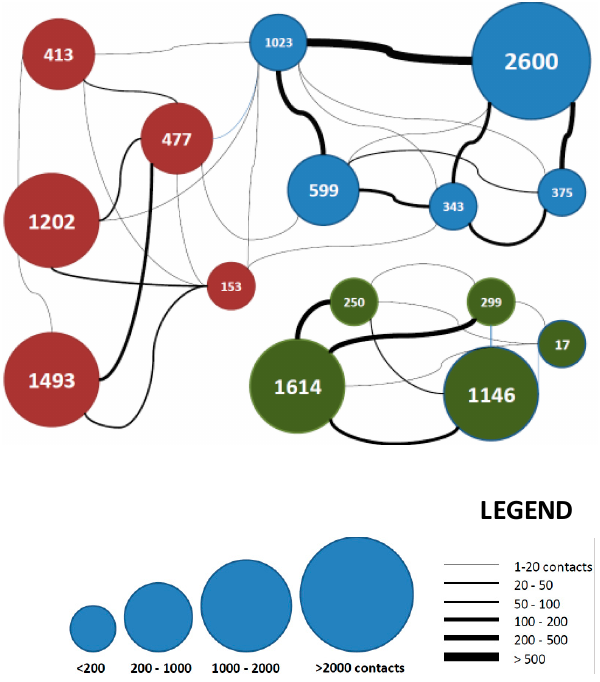
Figure 16. Contact graph of participating devices.